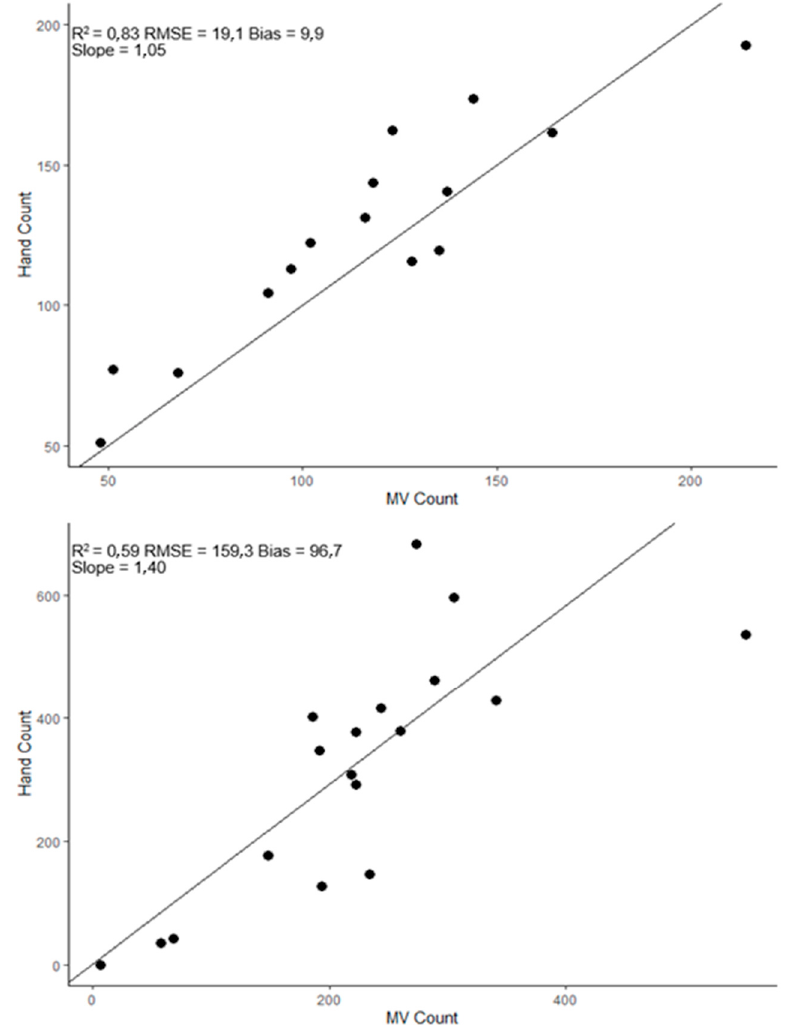
Figure 5. Manual tree fruit counts plotted against multi view machine vision estimates of mango tree fruit load for an orchard of smaller, open canopy trees ( top panel ) and larger, dense canopy trees ( bottom panel ). Units for RMSE and bias are counts of fruit per tree.